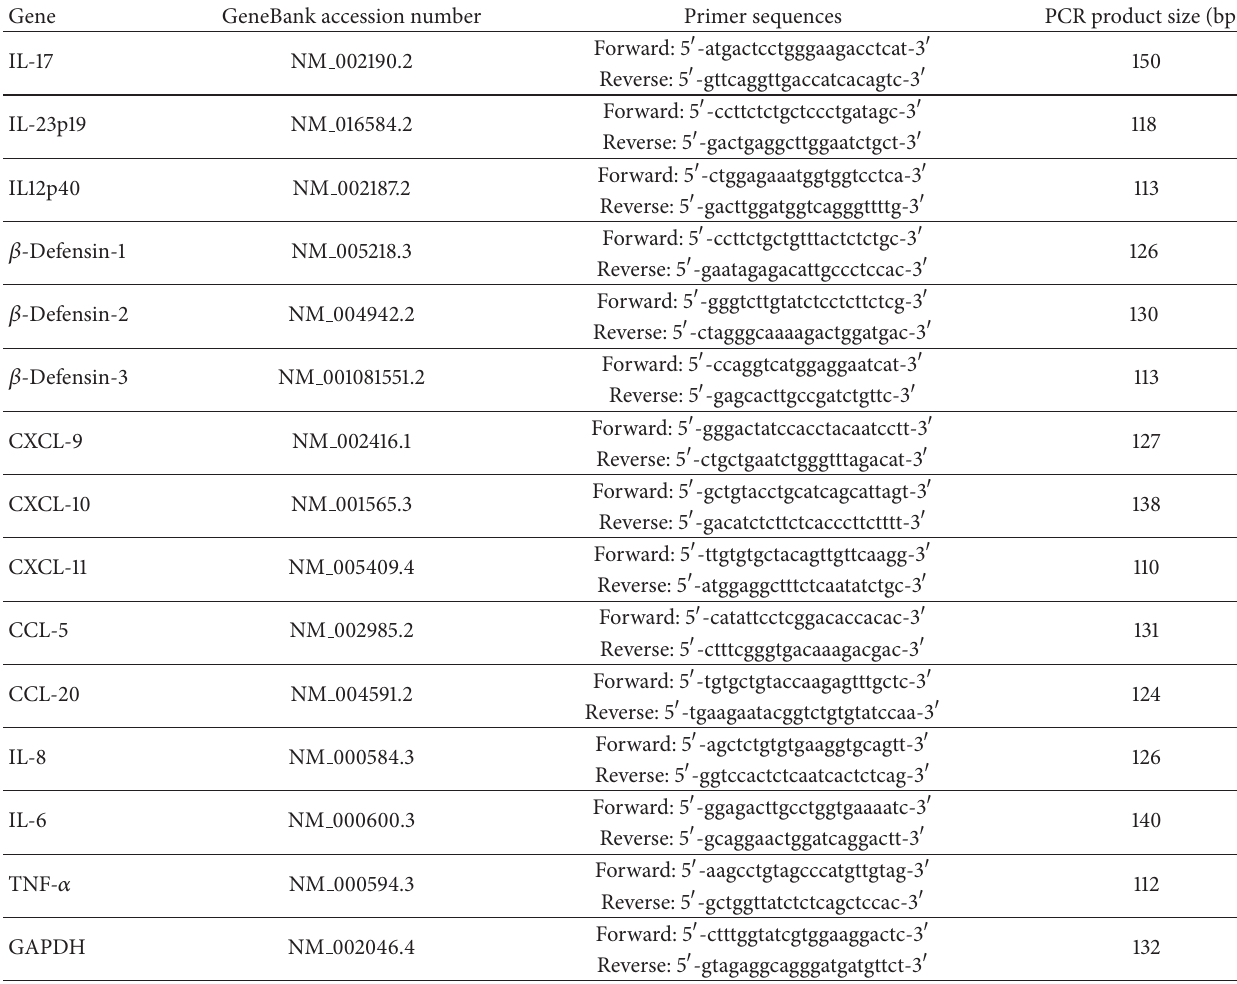
Table 2: Primer design for real-time quantitative